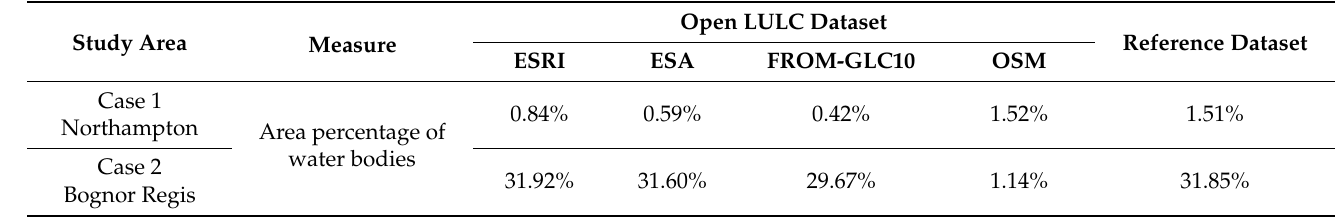
Table 2. Area percentage of water bodies of the two urban areas in Figure 4, calculating using different LULC datasets.